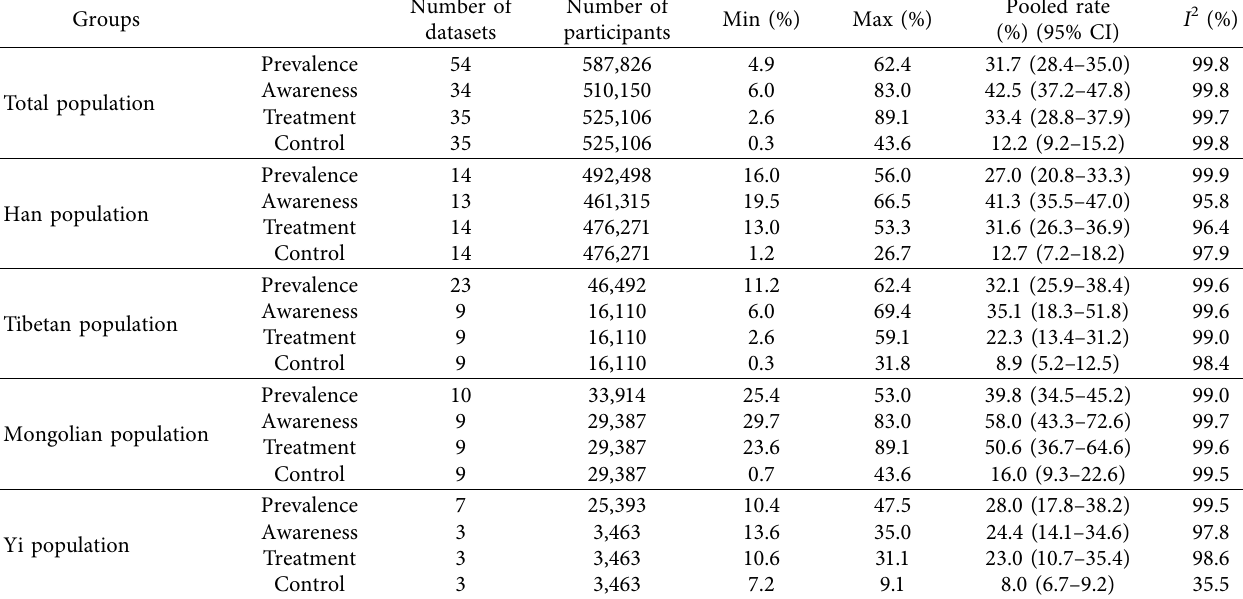
Table 1: Prevalence, awareness, treatment, and control of hypertension by survey year, ethnicity groups.